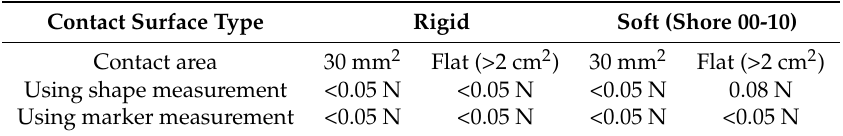
Table 1. The minimum distinguishable force of the fingertip GelSight (Setup shown in Figure 14a, using the shape measurement and marker measurement respectively. The sensor elastomer has a neo-Hookean coefficient of 0.145 MPa. Since we use an ATI Nano-17 force/torque sensor to calibrate GelSight force measurement, and minimum distinguishable normal force for the setup is 0.05 N, we are not able to get finer measurement of the minimum force when using marker measurement.